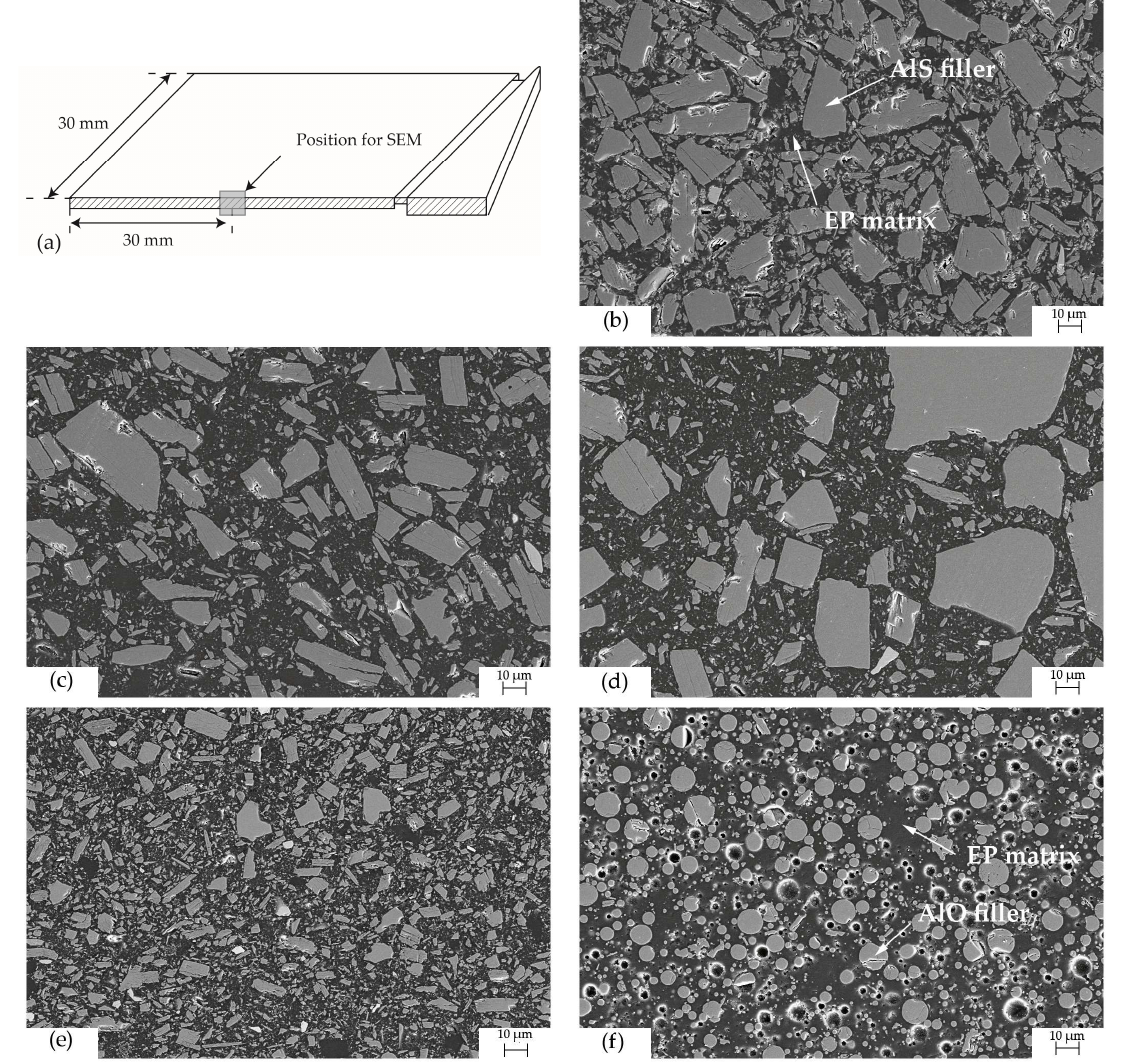
Figure 8. Microstructure of fillers in injection molded parts. ( a ) Position for SEM. ( b ) EP with 57 vol % AlS (Silatherm 1360-010); ( c ) EP with 38 vol % AlS (Silatherm 1360-010); ( d ) EP with 38 vol % AlS (Silatherm 1360-007); ( e ) EP with 38 vol % AlS (Silatherm 1360-400); ( f ) EP with 37 vol % AlO (Silatherm Plus 1432-400).